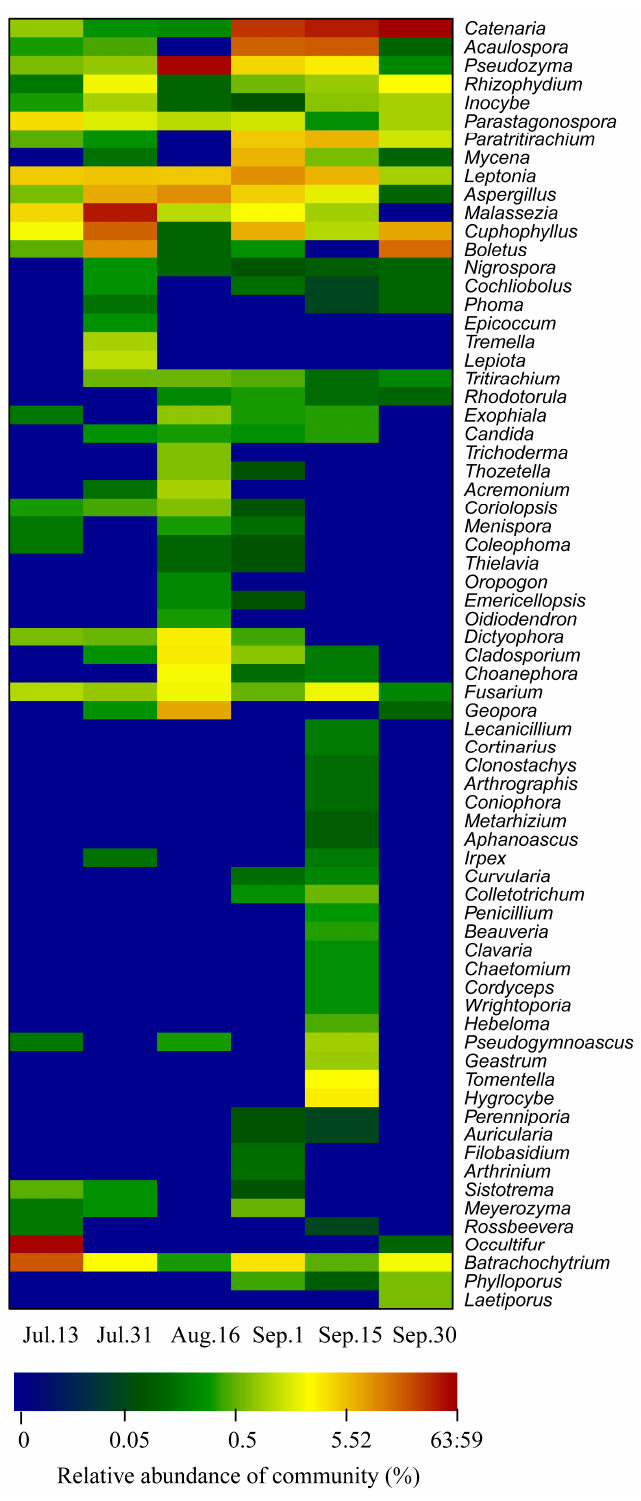
Figure 7. Heat map showing 70 representative predominant fungal ITS gene based sequence classified at the genus level in Zhoucun drinking water reservoir during algal bloom outbreak and decline from July to September, 2012. Blue colors indicate lower abundance, and red colors indicate higher abundance.